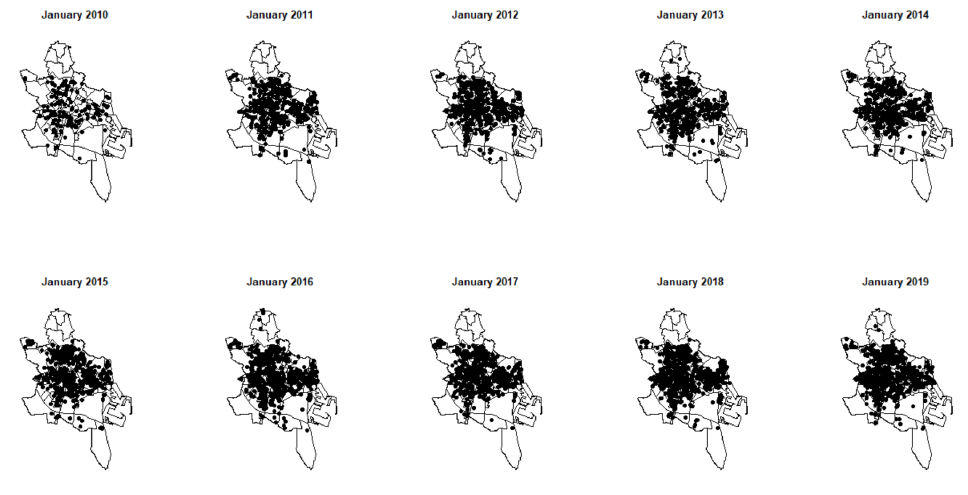
Figure 7. Spatial point patterns of the emergency calls for the month of January of each year between 2010 and